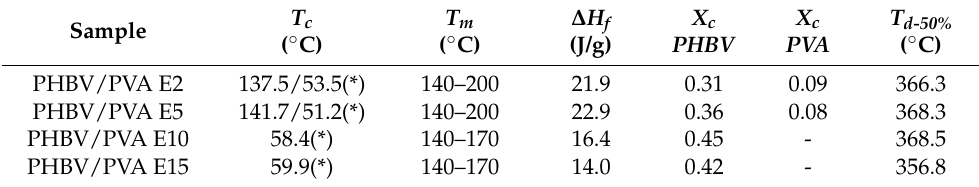
Table 4. Crystallization ( T c ) and melting ( T m ) temperature, enthalpy of fusion ( ∆ H f ), degree